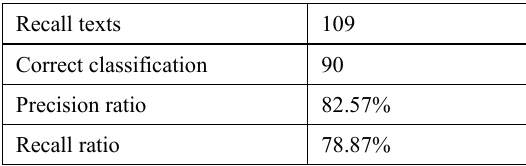
Table 2. Precision and recall